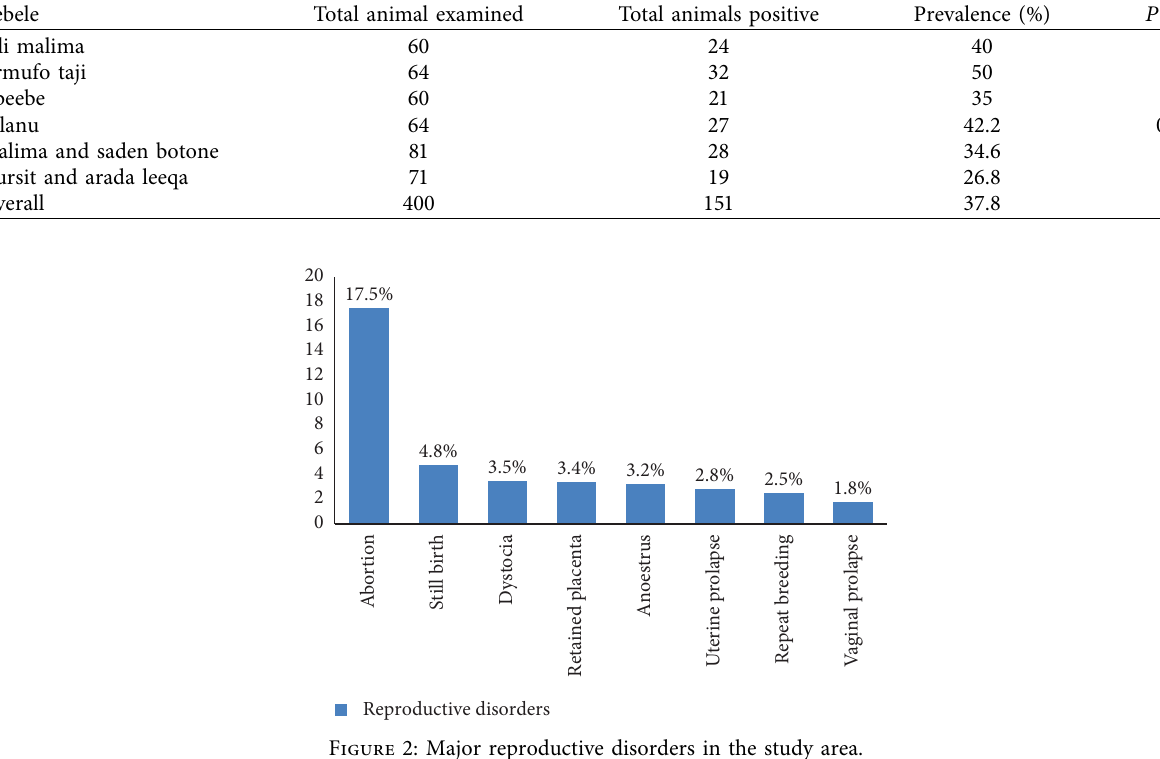
Table 1: Distribution of the prevalence of reproductive disorders in cattle in the study area.